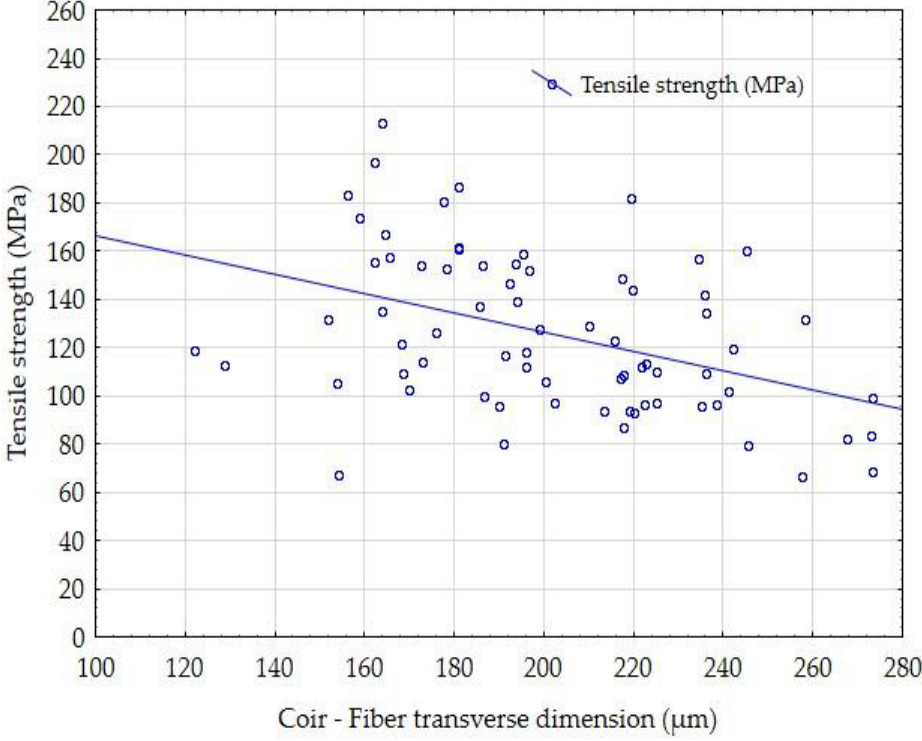
Figure 11. Comparison of the influence of the fiber transverse dimension of the coir on the tensile strength.